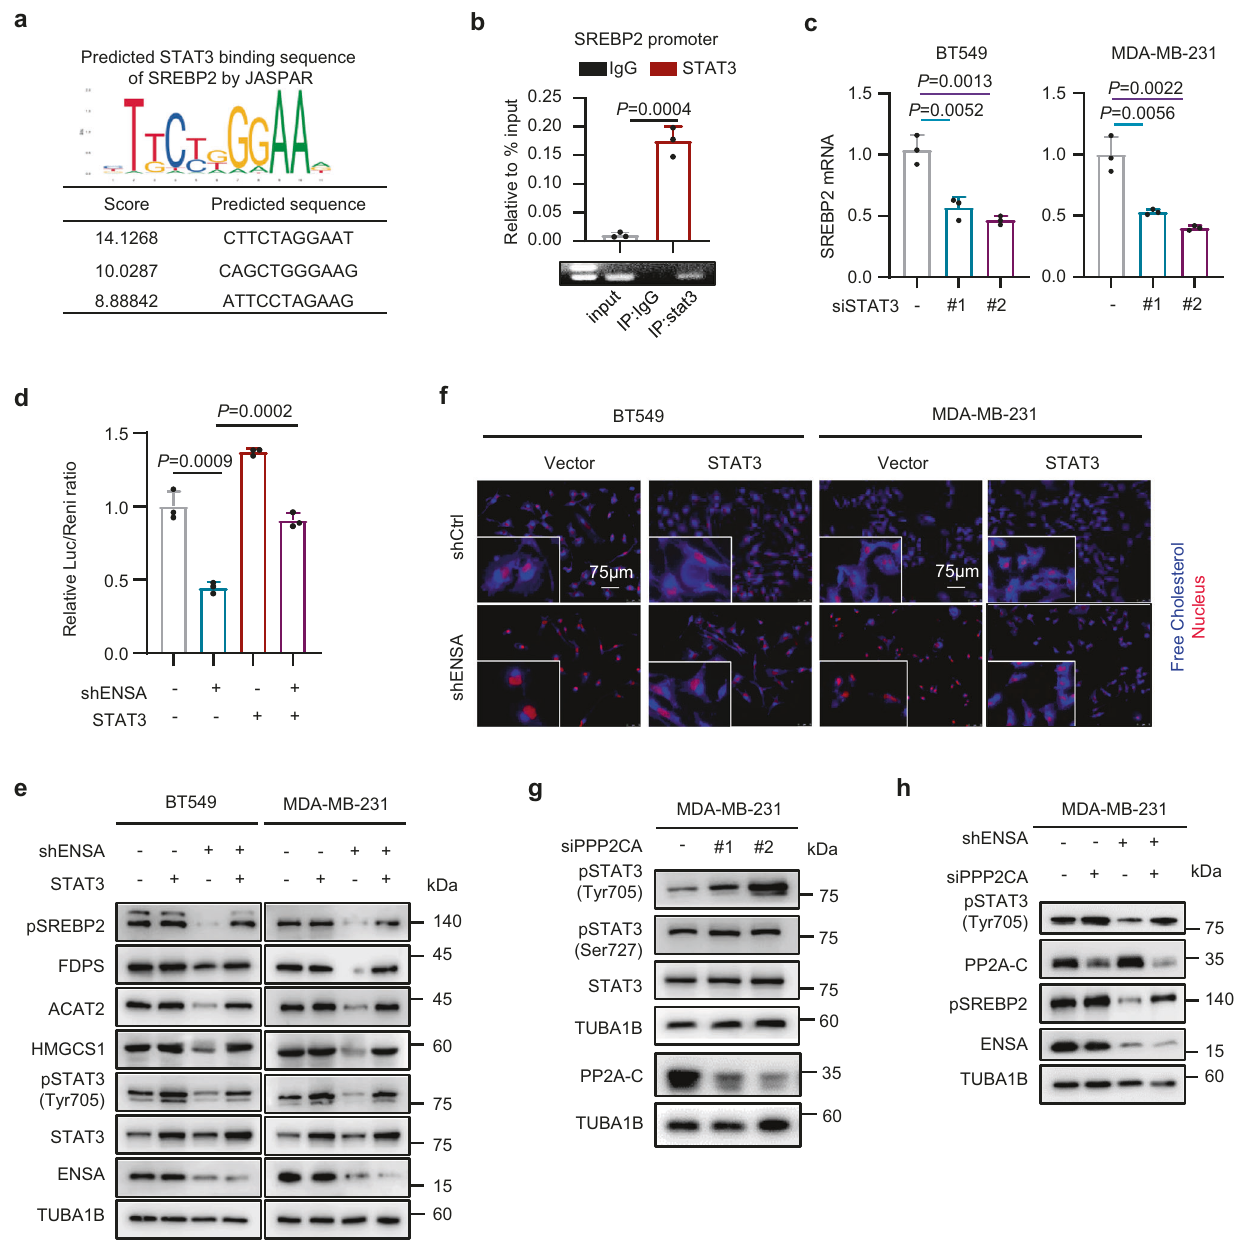
Fig. 5 ENSA activates STAT3 to promote the transcription of SREBP2 in a PP2A-dependent manner. a JASPAR prediction of STAT3-binding sites on the sequence of SREBP2. b qRT-PCR and PCR analysis of STAT3 at the SREBP2 promoter after ChIP assays in MDA-MB-231 cells expressing control or ENSA shRNA. n = 3. Data are presented as mean ± SD. Two-tailed unpaired Student ’ s t tests. c qRT-PCR detecting relative SREBP2 mRNA expression in BT549 and MDA-MB-231 cells after STAT3 transient silencing. n = 3. Data are presented as mean ± SD. Two-tailed unpaired Student ’ s t tests. d Luciferase reporter assay detecting the activity of the SREBP2 promoter in BT549 cells ± ENSA knockdown and ± STAT3 overexpression. n = 3. Data are presented as mean ± SD. Two-tailed unpaired Student ’ s t tests. e Western blotting images showing the expression of enzymes involved in cholesterol biosynthesis, SREBP2, pSTAT3-Tyr705 and total STAT3 in BT549 and MDA-MB-231 cells with ± ENSA knockdown and ± STAT3 overexpression. n = 3 independent experiments. f Filipin III staining showing the cellular free cholesterol contents of BT549 and MDA-MB-231 cells ± ENSA knockdown and ± STAT3 overexpression. n = 3 independent experiments. g Western blotting images showing the expression of STAT3, pSTAT3-Tyr705, and pSTAT3-Ser727 in MDA-MB-231 cells expressing control or PPP2CA siRNA. n = 3 independent experiments. h Western blotting images showing the expression of pSTAT3- Tyr705 and SREBP2 in MDA-MB-231 cells ± ENSA knockdown and ± transient PPP2CA knockdown. n = 3 independent experiments. Source data are provided as a Source Data fi